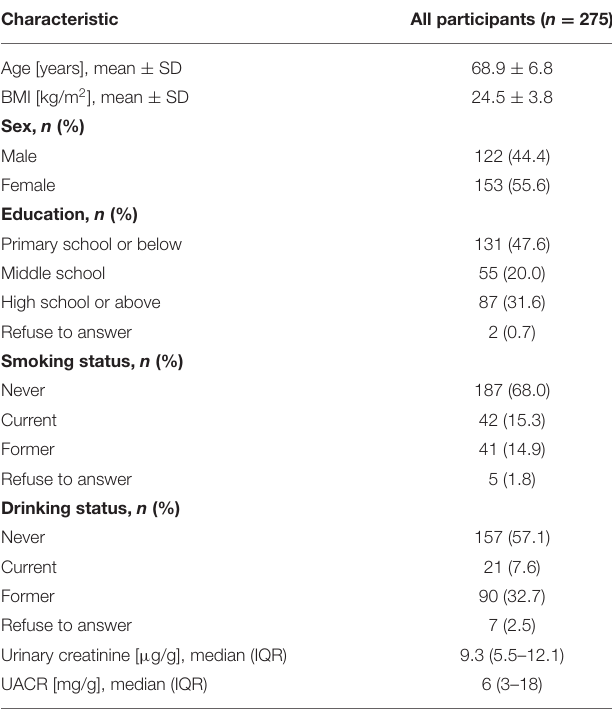
TABLE 1 | Baseline information of the study participants ( n =